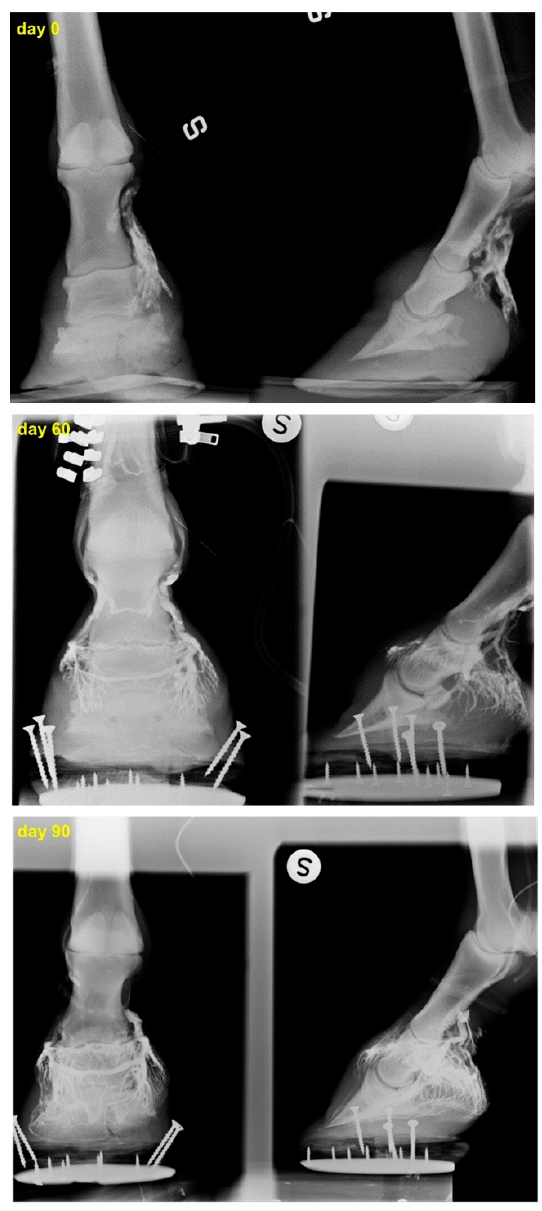
Figure 2. Case 8: venograms of the left foot. Increased venous filling is observed 60 days after the first